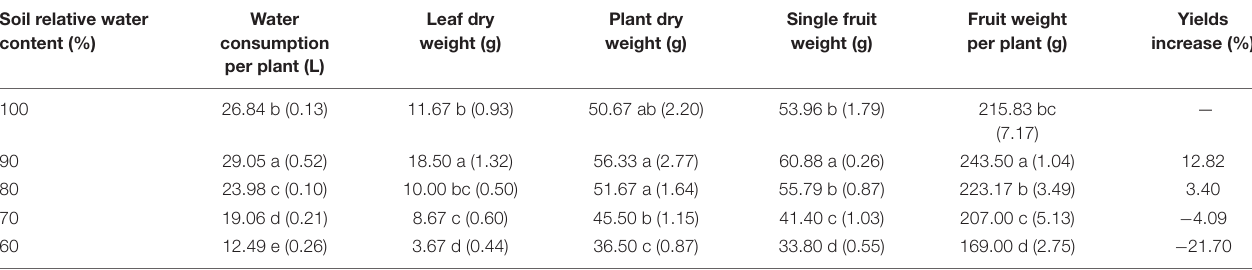
TABLE 4 | Effect of different water supplies on yields of tomatoes.